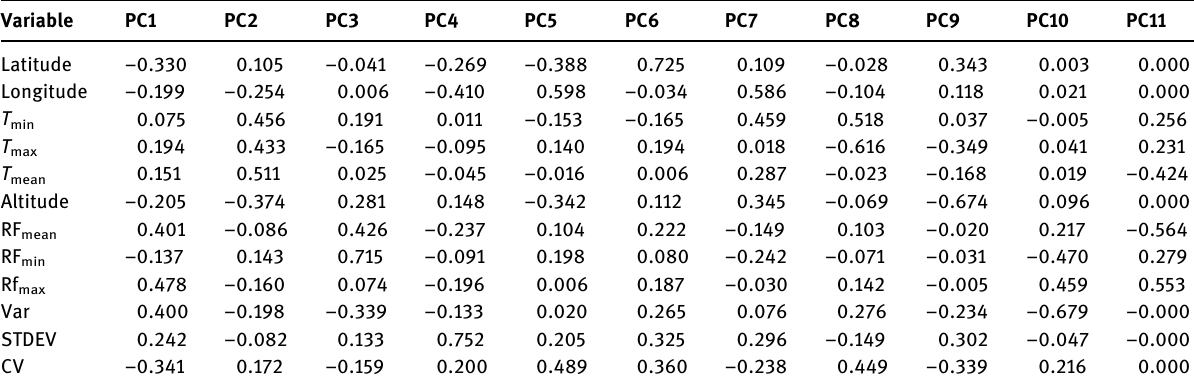
Table 3: Eigen vectors for FMAM